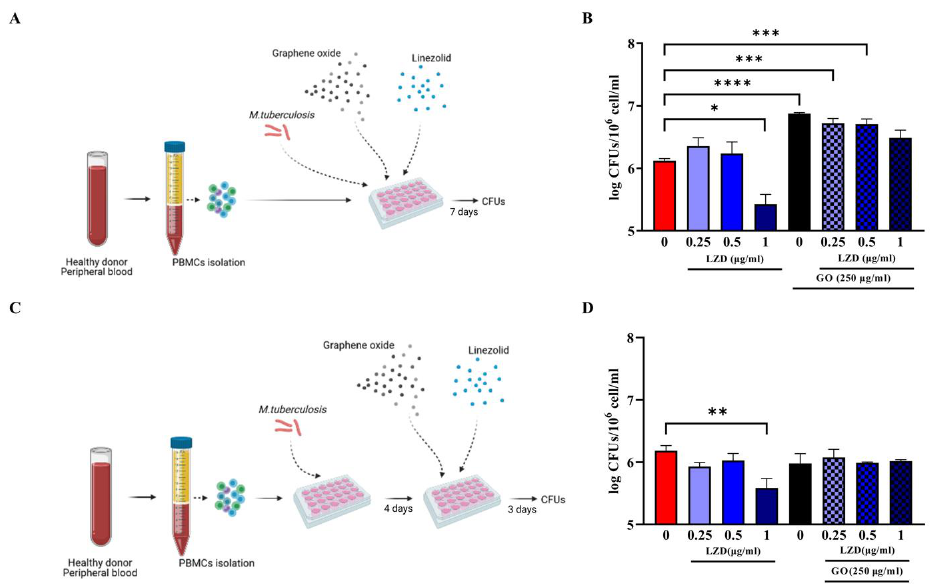
Figure 1. Effect of GO-LZD combination during Mtb in ex vivo hPBMC infection model. The GO-LZD effect on Mycobacterium tuberculosis survival was evaluated in ex vivo human PBMC infection model. Graphene Oxide at a final concentration of 250 µ g/mL was administered alone or in combination with LZD at a final concentration of 0.25, 0.5 and 1 µ g/mL. Peripheral Blood Mononuclear Cells were infected with 6 × 10 4 CFUs of Mtb H37Rv strain (Multiplicity Of Infection, MOI 1:1 based on monocyte percentages) and GO or GO+LZD solutions were administered as co-infection treatment or as 4 days post-infection treatment. Schematic representations of experimental